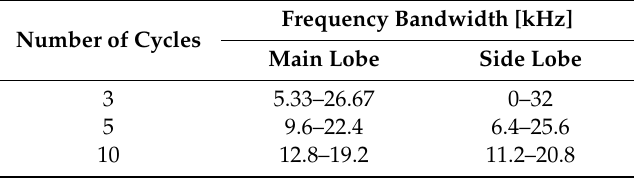
Table 4. Number of cycles studied and its representative frequency bandwidth.